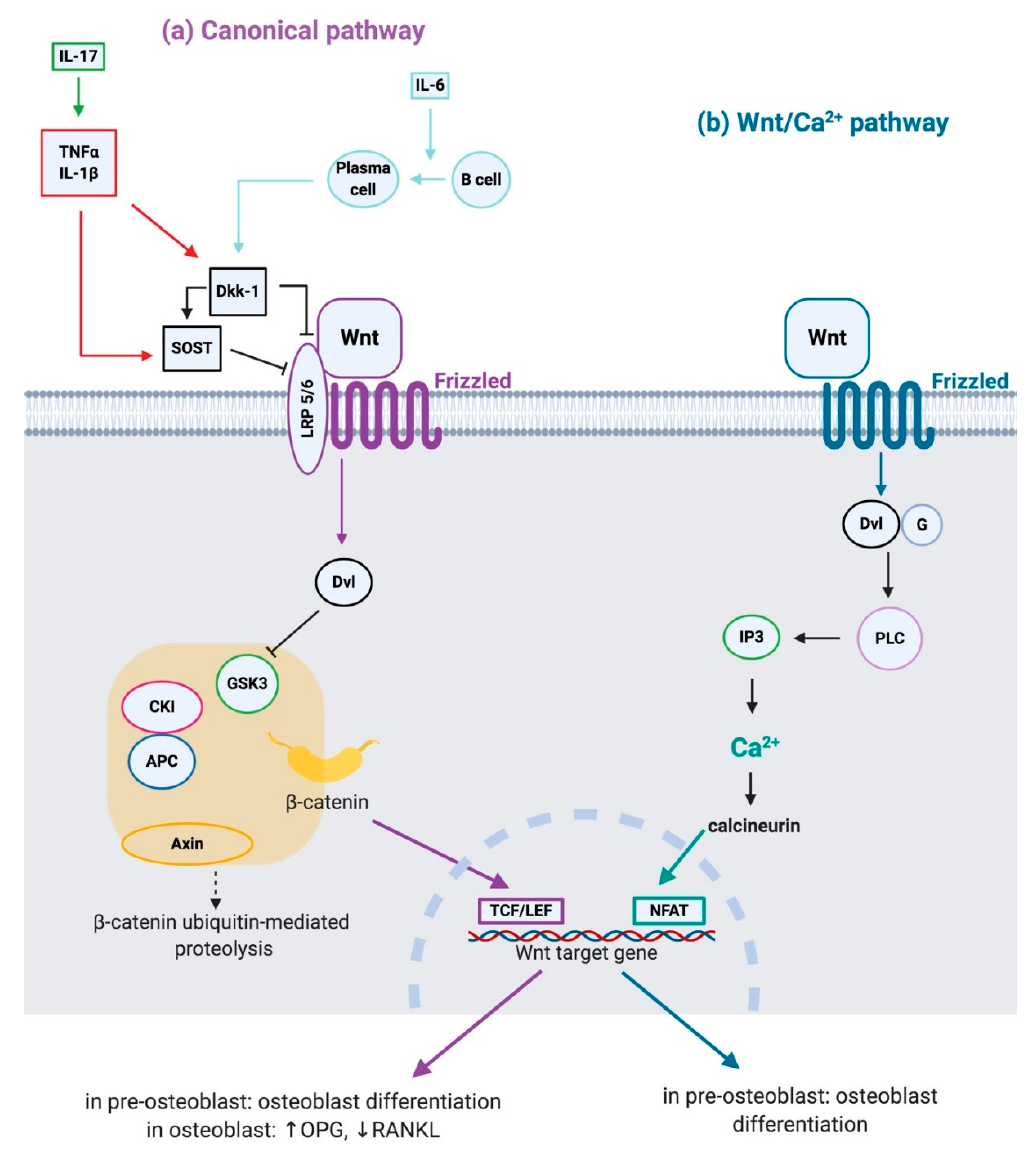
Figure 1. Wnt signaling pathways. ( a ) Canonical Wnt pathway: in the absence of Wnt ligands, β -catenin is degraded by a complex composed of glycogen synthase kinase-3 β (GSK3), caseine kinase I (CKI), adenomatous polyposis coli (PCI) and Axin. Wnt proteins binding to their coreptor complex (Frizzled + low-density lipoprotein receptor-related protein (LRP) 5 / 6) leads to inhibition of GSK3 mediated by disheveled (Dvl) protein. In this condition, β -catenin translocates into the nucleus and together with T-cell factor (TCF) / lymphoid enhancer factor 1 (LEF) induces the expression of Wnt target genes, leading to osteoblast di ff erentiation, up-regulation of osteoprotegerin (OPG) and down-regulation of Receptor activator of nuclear factor-kappa B ligand (RANKL). Dickkopf (Dkk) protein and sclerostin (SOST) inhibit this pathway by binding LRP5 / 6; moreover, Dkk-1 induces SOST. Pro-inflammatory cytokines tumor necrosis factor (TNF) α and interleukin (IL)-1 β induce Dkk-1 and SOST; IL-17 down-regulates Wnt canonical pathway indirectly, enhancing the production of TNF α and IL-1 β ; furthermore, IL-6 induces di ff erentiation of B cells into plasma cells which express Dkk-1. ( b ) Wnt / Ca 2 + pathway: Wnt proteins binding to the Frizzled receptor lead to the activation of Dvl via activation of G-proteins (G). Dvl leads to cytoplasmic calcium (Ca 2 + ) release from the endoplasmic reticulum via phospholipase C (PLC) and inositol 1,4,5-trisphosphate (IP3). Intracellular Ca 2 + in turn activates calcineurin, which activates the nuclear factor of activated T-cells (NFAT), inducing the expression of Wnt target genes, leading to osteoblast differentiation.